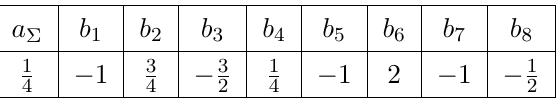
Table 2 . Defect central charges for the AdS 5 probe brane in AdS 6 in units of π 2 L 5